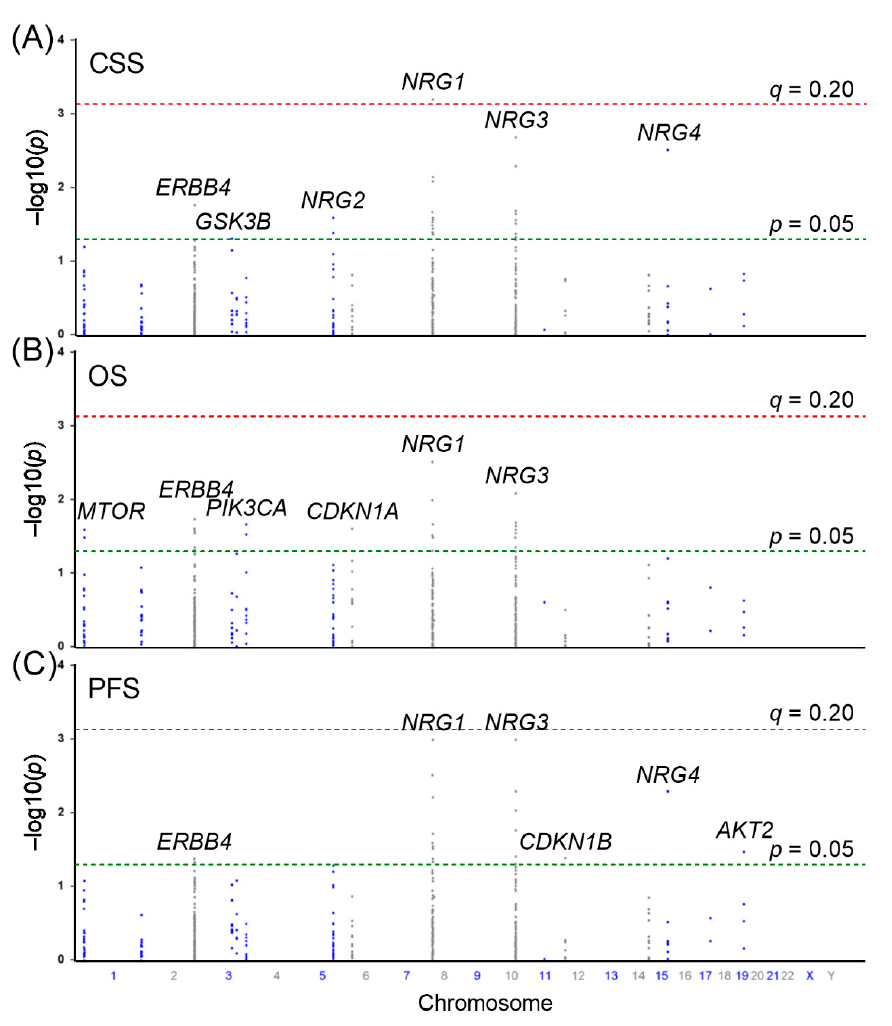
Figure 1. Manhattan plots of 459 single-nucleotide polymorphisms (SNPs) in 19 neuregulin (NRG) pathway genes with ( A ) cancer-specific survival (CSS), ( B ) overall survival (OS), and ( C ) progression-free survival (PFS) for patients with prostate cancer treated with androgen-deprivation therapy (ADT). The associations between SNPs and CSS, OS, and PFS are plotted as − log10 ( p ) values against their respective positions on the chromosomes. Genes are labelled if they contain associated SNPs, with p < 0.05. The red line denotes significance ( q = 0.20) and the green line denotes p = 0.05. Table 2. Association of NRG1 rs144160282 with CSS, OS, and PFS in prostate cancer patients re- ceiving ADT.